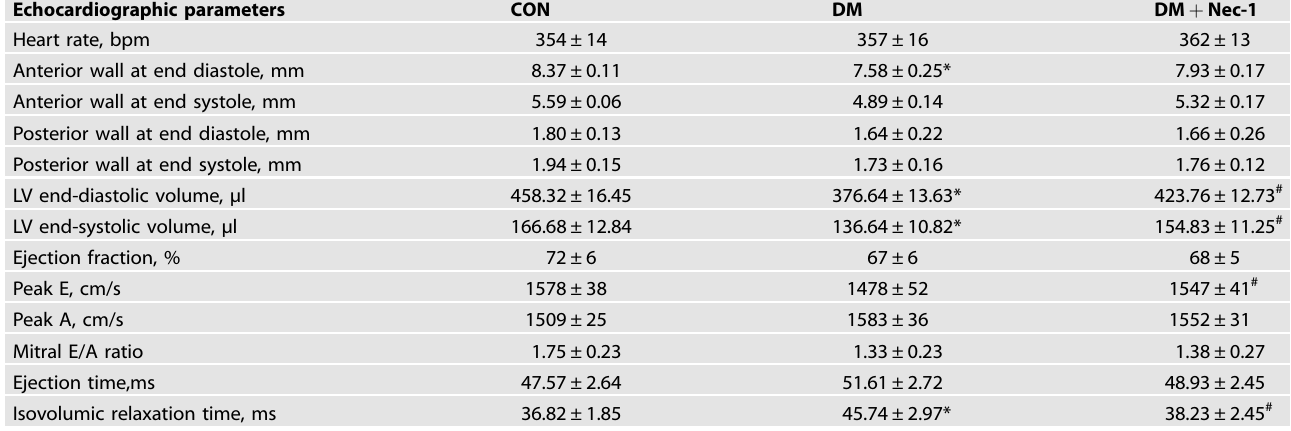
Table 1. Nec-1 improves cardiac function parameters in T2DM rats. Echocardiographic